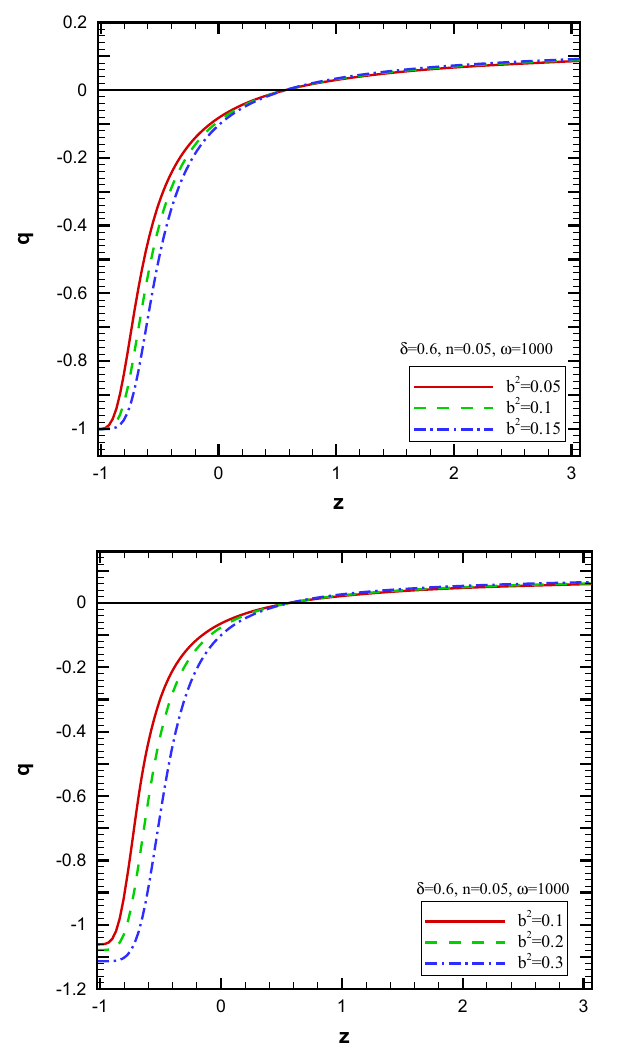
Fig. 7 The evolution of q versus z for the interacting THDE. We con- sidered (cid:3) k = 0 (upper panel), (cid:3) k 0 = 0 . 1 (lower panel), δ = 0 . 6, n = 0 . 05 and ω = 1000 as the initial conditions